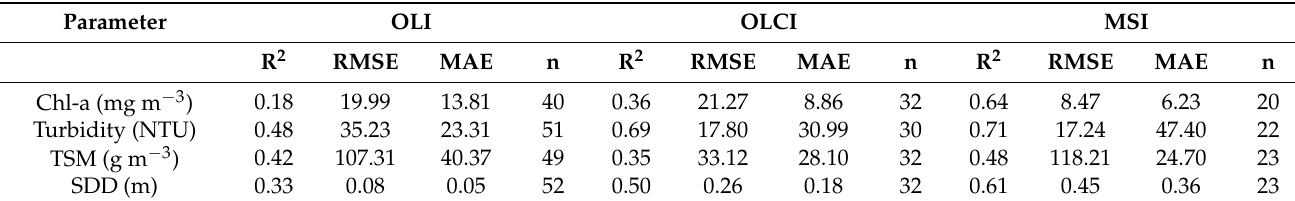
Table 3 . Average error metrics of the trained models by sensor and water parameter. Error metrics of all lakes are included on each water parameters RMSE: Chla in mg m − 3 , Turbidity in NTU, TSM in g m − 3 , SDD in m. The number of samples is also displayed on average.